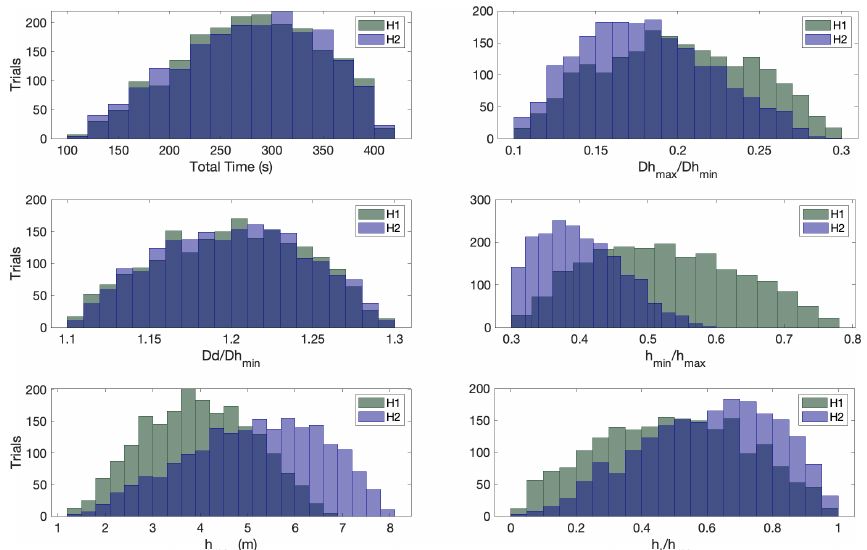
Figure 10. Input parameter distributions for two sets of hypothetical cases. Histograms of buried ruptures (H1) are depicted with dark-green colour and of splay-faulting (H2) with dark-blue